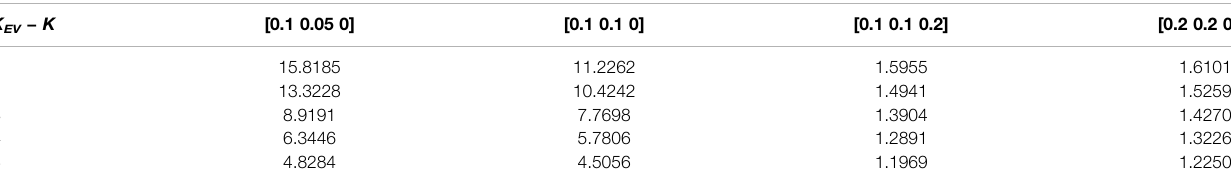
TABLE 6 | Delay margins for different values of K EV and K